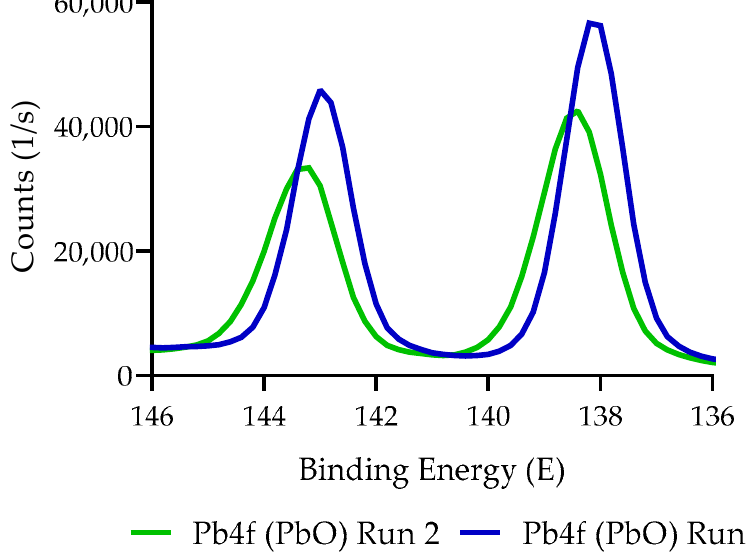
Figure 7. XPS analysis of the precipitate harvested from runs 2 and 3b.